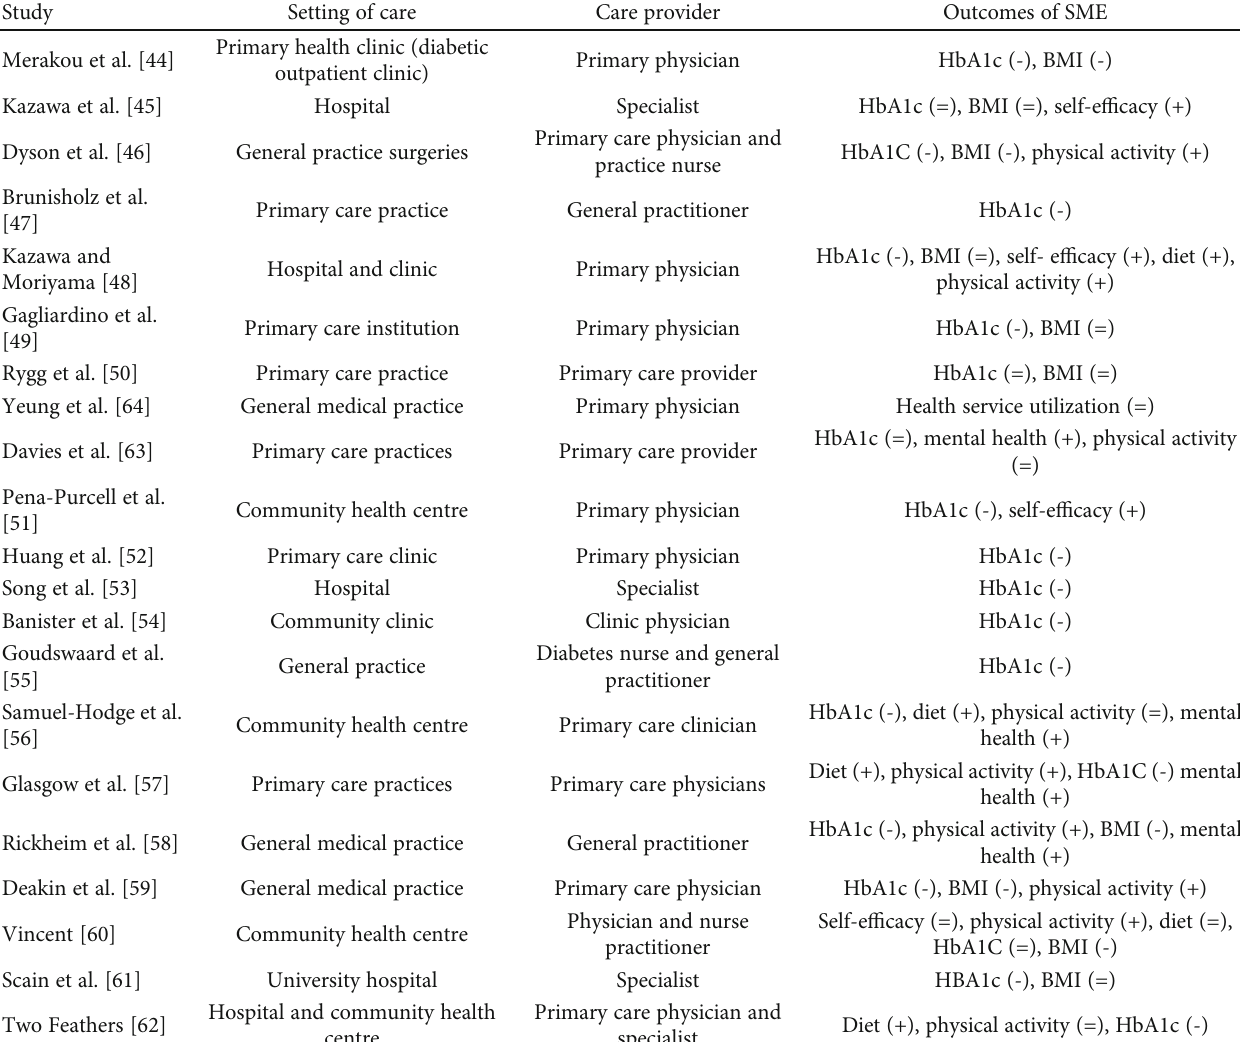
Table 4: Outcomes of DSME programs by type of care provider and setting of care.